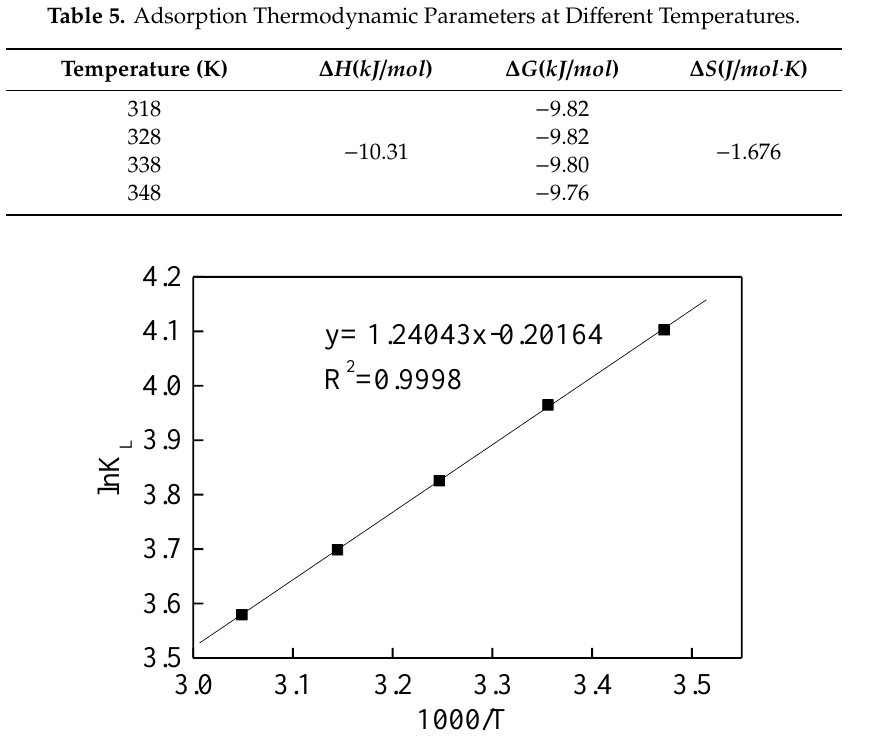
Figure 7. Correlations between 1000 / T and ln K L .